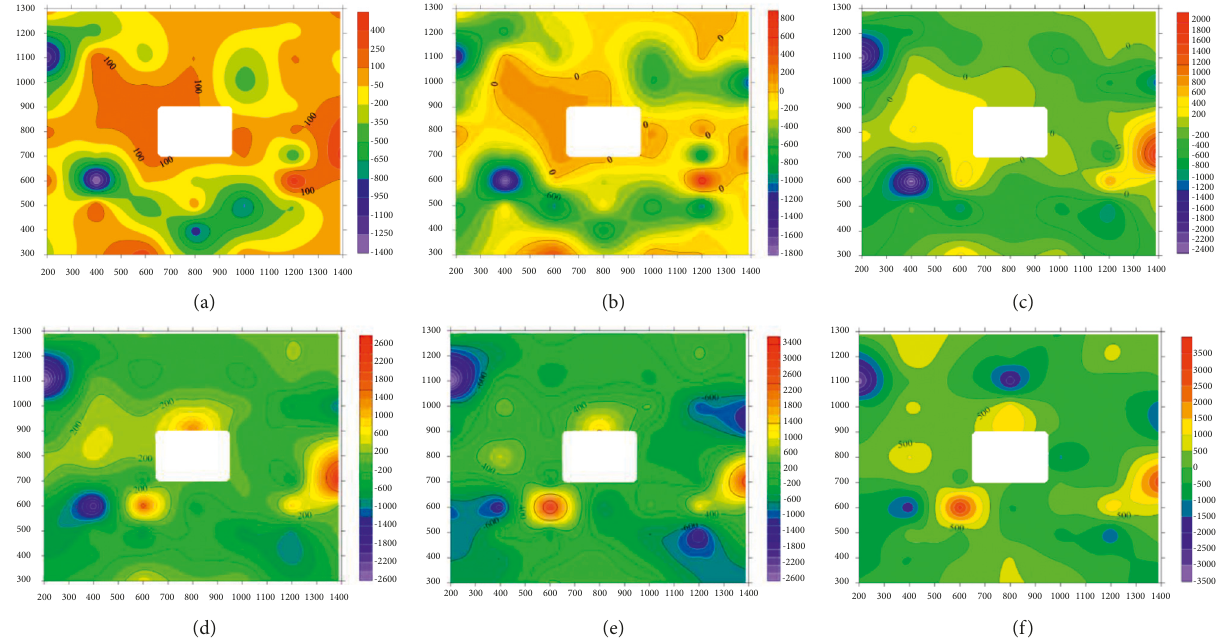
Figure 9: Evolution of vertical strain field under different loads; (a) Under load level 4; (b) Under load level 14; and (c)–(e) Under load level 23 and cumulative duration is 541mins, 542 mins, 543mins, and 544mins, respectively.